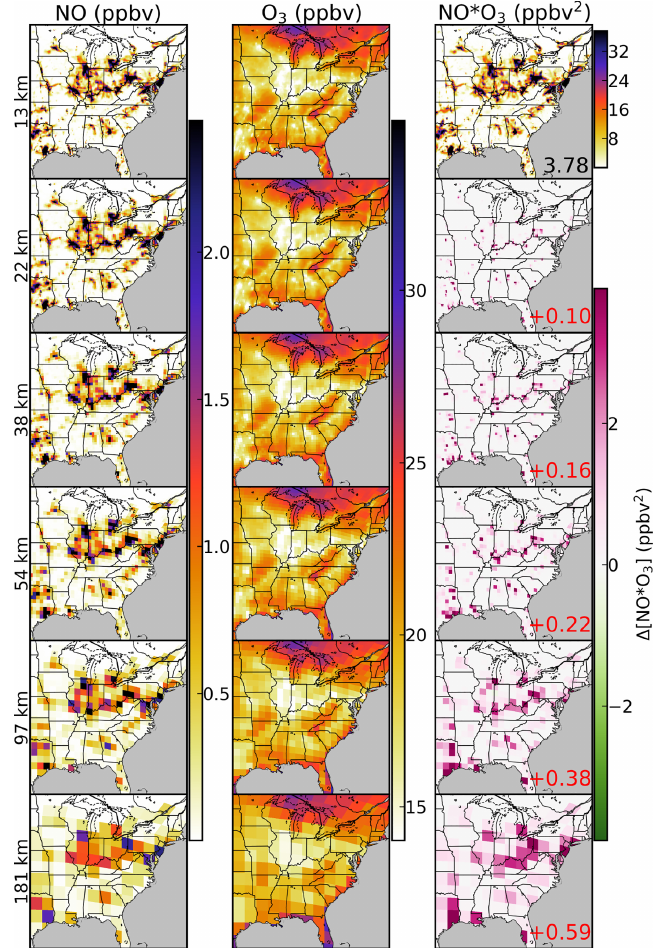
Figure A4. Illustration of the resolution-dependent nighttime NO–O 3 titration efficiency. The left and middle columns are mean surface NO and O 3 concentration at 00:00UTC + 6 in January 2015 at 13km (top row) and regridded to the other resolutions. The right column shows their products at 13km resolution and their differences if calculated at the other coarser resolutions. Domain mean products and differences are shown as an